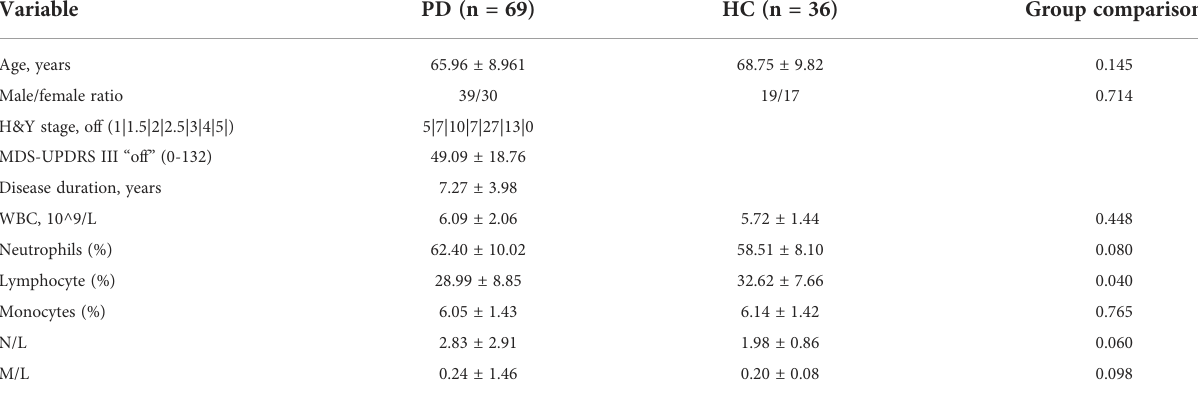
TABLE 1 The demographic data and clinical characteristics of participants in this study.